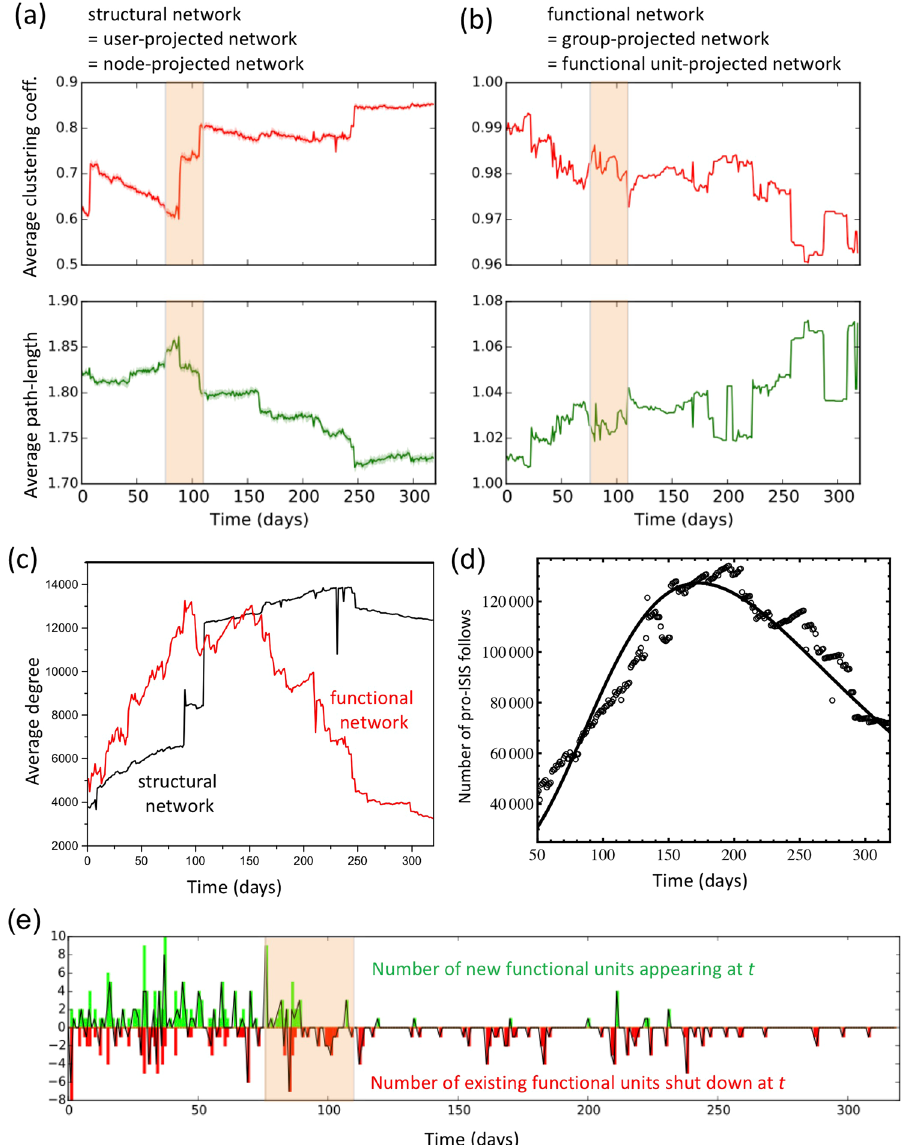
Figure 3. Continuous-time network properties. Temporal variation of the network properties from Fig. 1(a) after projecting onto ( a ) the nodes (i.e. users) giving the structural network, and ( b ) the functional units (i.e. online groups) giving the functional